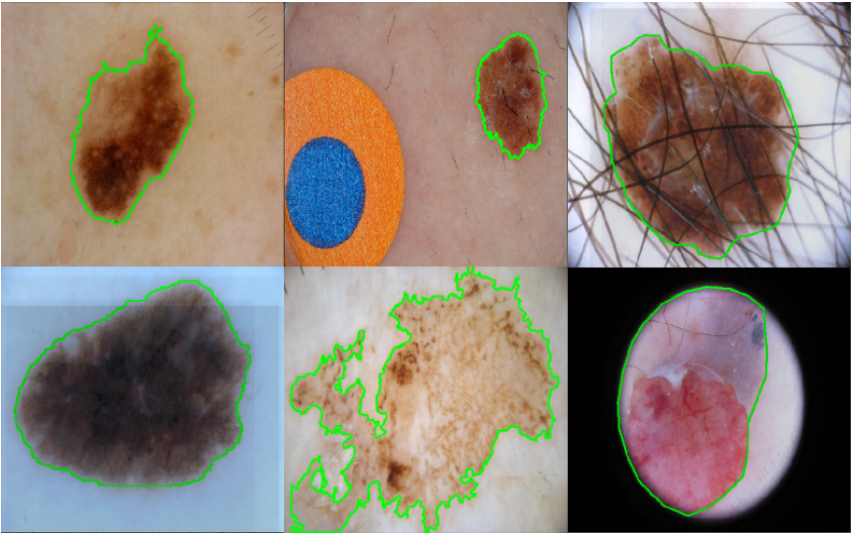
Figure 1. Some example images from the ISBI2017 dataset for skin lesion segmentation. The ground truth segmentation masks are marked using green contours. Fuzzy boundaries and distractions such as hairs and color-marks are also